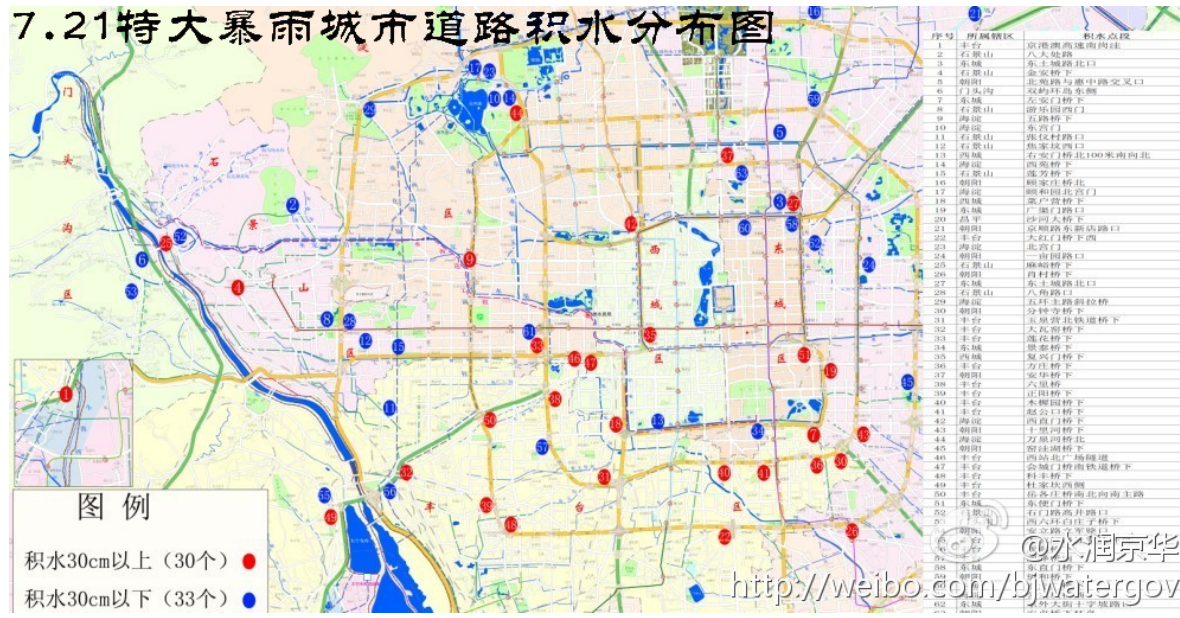
Figure 14: Beijing Water Authority Map generated for the flood of July 2012.